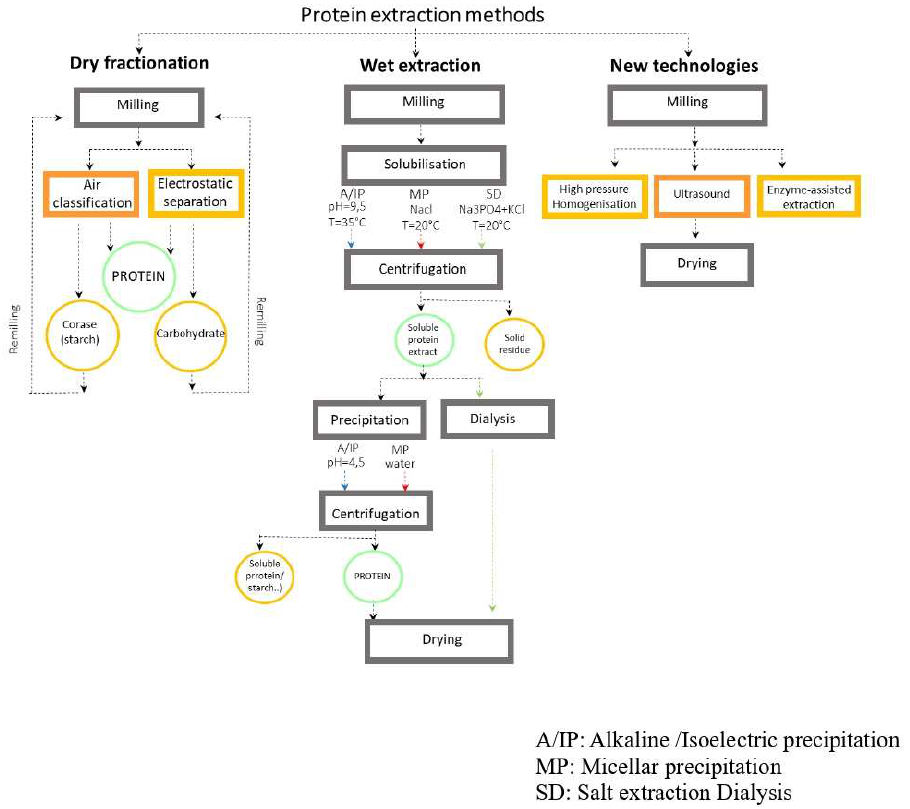
Figure 3. Legume protein extraction methods [29,44,75,79–88]. Seed properties including hardness, particle density, starch granule size, fat content and flour dispersibility influence the protein content during air classification [89]. Therefore, this technique is useful particularly for the production of protein-rich meals and flours (protein content up to about 60%) from non-oilseed legumes like peas [90]. For instance, protein extracted from legumes with low lipid content such as lentil and chickpea exhibited higher protein recovery rate and yield compared to other legumes such as broad and kidney bean [91]. However, it is difficult to fractionate legumes with high oil content by air classification [82]. In such seeds, oil may promote the cohesion between powder particles through viscous and capillary bridging, which negatively affects the dispersion of individual particles in air [74]. Hence, the air classification technique for lipid-contain- ing legumes might produce protein fractions with less purity [73]. Additionally, oil might soften the grain, giving it a ductile behaviour, and thus increasing milling energy demand [74]. Therefore, dry fractionation of protein is an appropriate technology only for the low lipid legumes. For oil-rich legumes, defatting prior to dry fractionation would be a straightforward approach to obtain higher protein content and purity [74,92]. Furthermore, the difference in the particle size of protein and starch affects the sepa- ration process. It was demonstrated that the smaller protein-rich fragments could be sep- arated efficiently [89]. However, the protein separation efficiency reduces by the decrease in size of starch or the increasing ratio of damaged or broken starch granules. As a conse- quence, their differentiation from protein bodies become difficult [81]. Unlike air classification, the electrostatic separation, which is one of the eco-innova- tive technologies [93] is based on differences in dielectric properties of flour particles in- stead of their size and density [94]. However, this difference does not have any advantage on the purity of plant protein isolate/concentrates, including legumes [29]. Based on the methods used to impart surface charge, three main types of electrostatic separators are